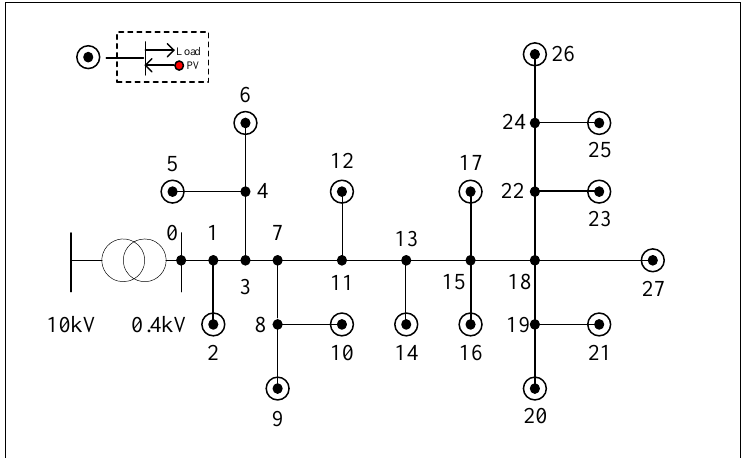
Figure 1. Low-voltage Distribution Network Model with 27 nodes, where circled nodes represent a set of photovoltaic (PV) inverters and loads (2,5,6,9,10,12,14,16,17,20,21,23,25,26,27). Each PV unit connects to an agent that is adapted to measure, compute, and adjust outputs. The top layer communication network is shown in Figure 2. Each agent only interacts with its neighbors, where degree d i = 2. Agent i measures its local information and adjacent agents’ information, i.e., p i , q i , u i , p j , q j , and u j , and then controls the voltage by control laws, which are given in Sections 3.2 and